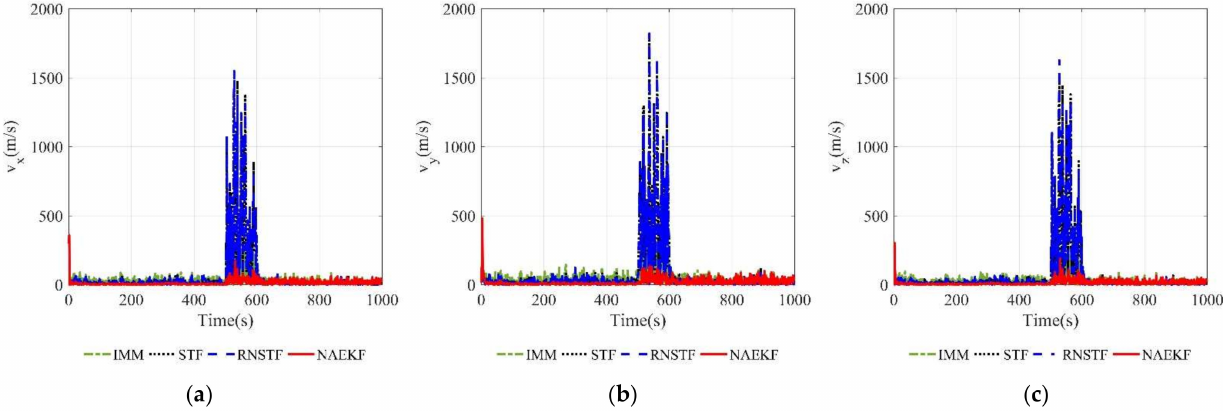
Figure 14. Velocity estimation errors. ( a ) Estimation errors of v x ; ( b ) Estimation errors of v y ; ( c ) Estimation errors of v z .